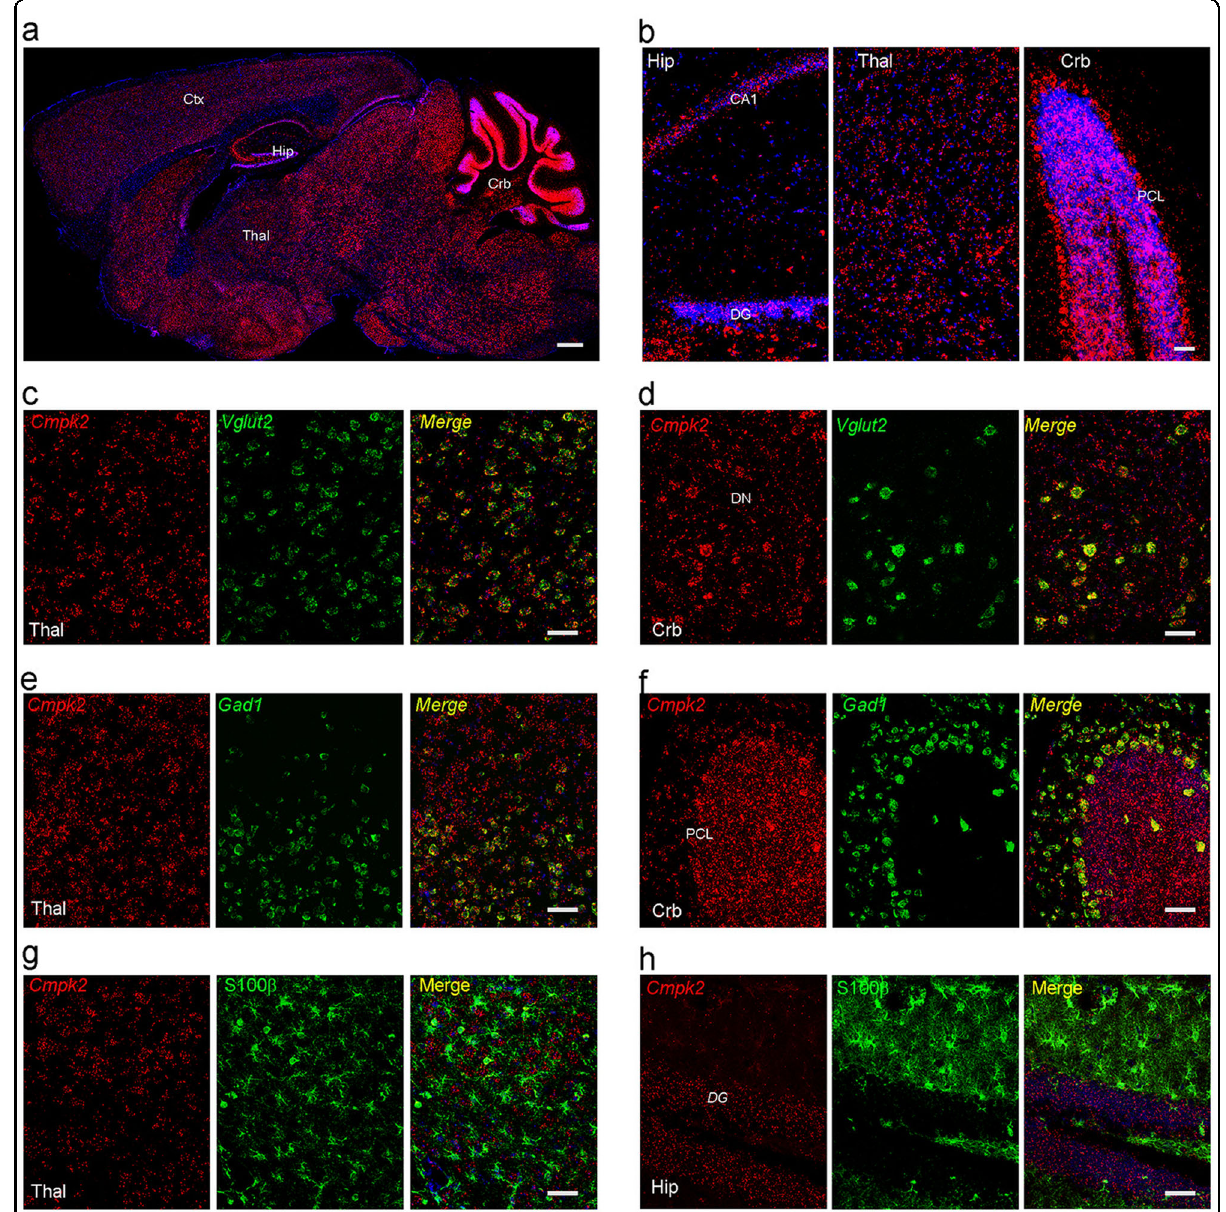
Fig. 3 Cmpk2 is expressed in mouse neurons. a In situ hybridization of Cmpk2 expression in adult mouse brain sagittal sections. b Enlarged view of Cmpk2 expression in the hippocampus, thalamus, and cerebellum; DAPI (blue) staining of nuclei. c , d Dual in situ hybridization of Cmpk2 (red) with the glutamatergic neuronal marker Vglut2 (green) in the mouse thalamus ( c ) and dentate nuclei of the cerebellum ( d ). e , f Dual in situ hybridization of Cmpk2 (red) with the GABAergic neuronal marker Gad1 (green) in the mouse thalamus ( e ) and the PCL of the cerebellum ( f ). g , h Double fl uorescence labeling of Cmpk2 (red) and the astrocytes marker S100 β (green) in the thalamus ( g ) and DG of hippocampus ( h ). Ctx cortex, Hip hippocampus, Thal thalamus, Crb cerebellum, DG dentate gyrus, PCL Pukinje cell layer, GCL granule cell layer. Scale bars, 500 μ m in a ; 50 μ m in b – h